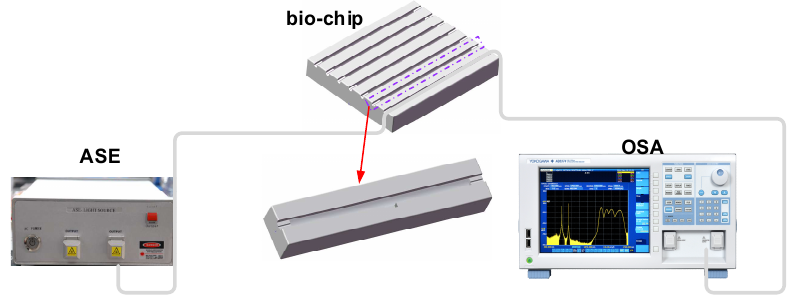
Figure 5. Experimental setup for the biosensing structural characterization.